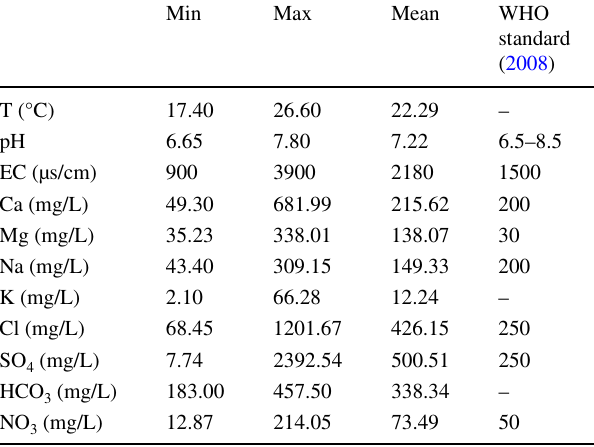
Table 1 Analytical result for physico-chemical and major ions